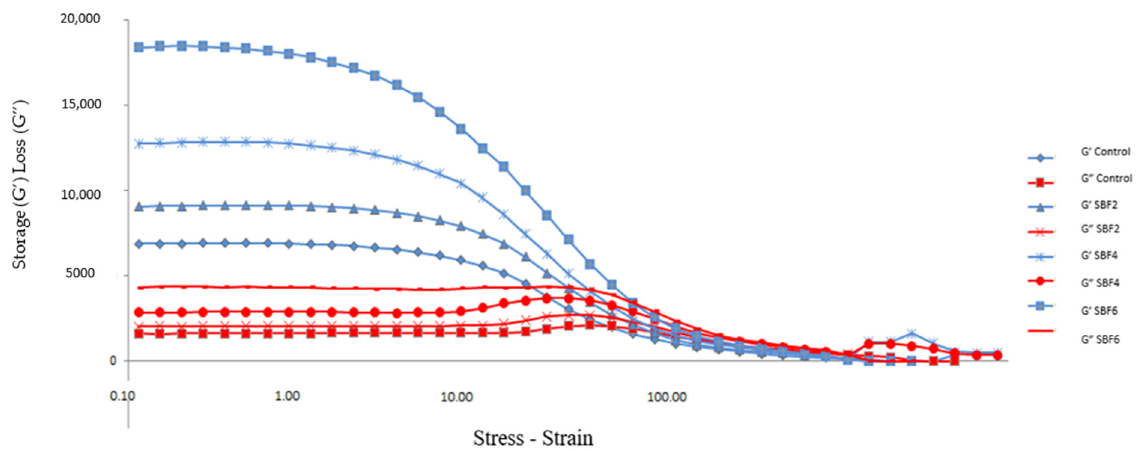
Figure 2. Rheological properties (strain-sweep test) of chicken batter with the addition of Saba banana peel. Data for SBF2, SBF4 and SBF6 adapted from [4].